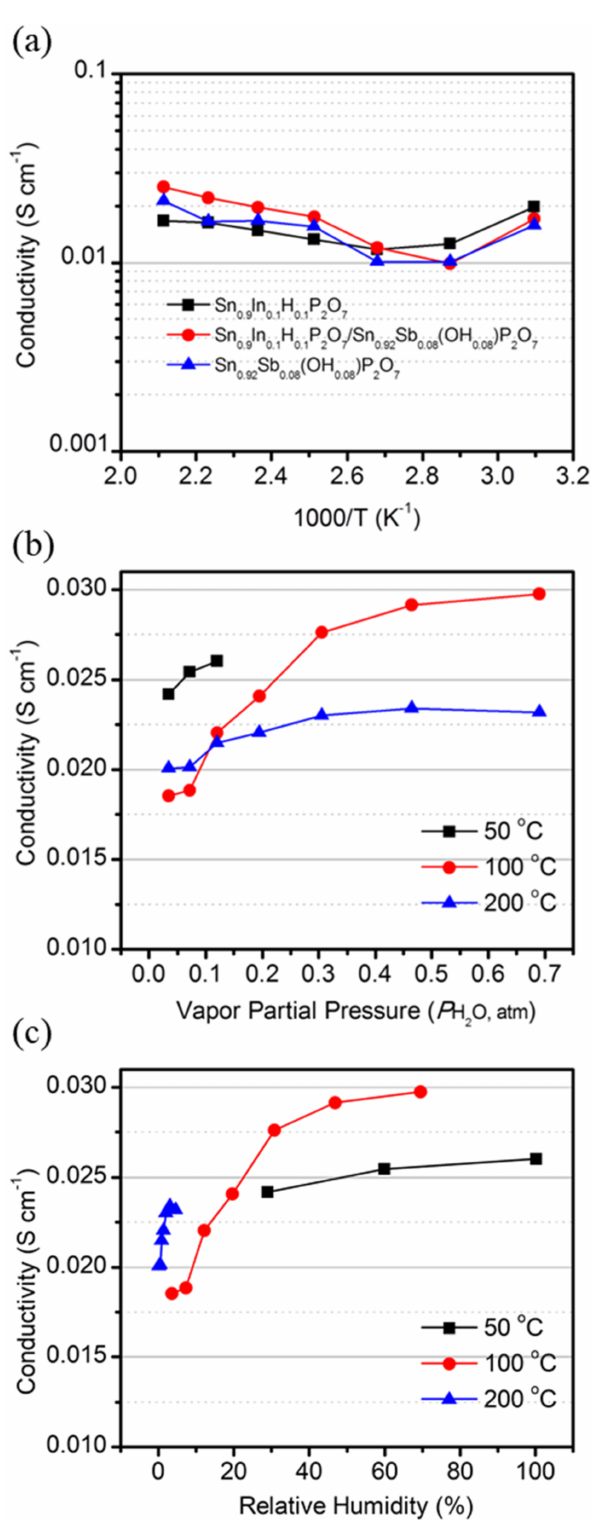
Figure 2. ( a ) Temperature dependency of electrical conductivity for Sn 0.9 In 0.1 H 0.1 P 2 O 7 , Sn 0.92 Sb 0.08 (OH) 0.08 P 2 O 7 , and Sn 0.9 In 0.1 H 0.1 P 2 O 7 /Sn 0.92 Sb 0.08 (OH) 0.08 P 2 O 7 membranes. The measurement was conducted under open-circuit conditions at operating temperatures (50–200 ◦ C) in air saturated with H 2 O vapor at room temperature. ( b ) P H 2 O and ( c ) RH dependency of electrical conductivity for Sn 0.9 In 0.1 H 0.1 P 2 O 7 /Sn 0.92 Sb 0.08 (OH) 0.08 P 2 O 7